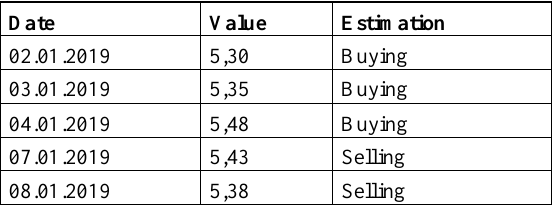
Table 1: One Week Sample USD/TRY Data Set